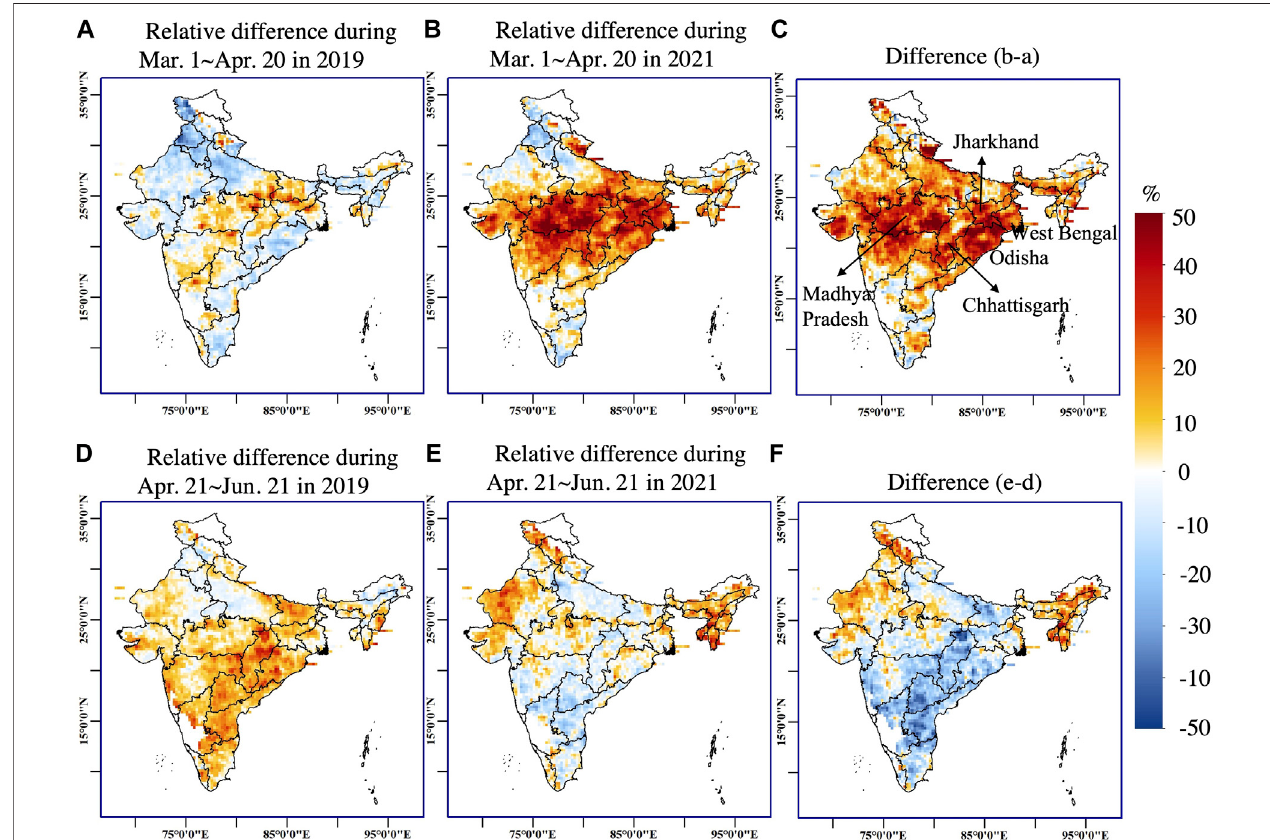
FIGURE 3 | Spatial distributions of NO2 TVCD relative change during Mar. 1~Apr. 20 in 2019 (A) and 2021 (B) , and their difference (C) ; and during Apr. 21~Jun. 21 in 2019 (D) and 2021 (E) , and their difference (F) . Pixels with 10-years means smaller than 1 ×10 15 molec/cm 2 are not plotted in the maps.